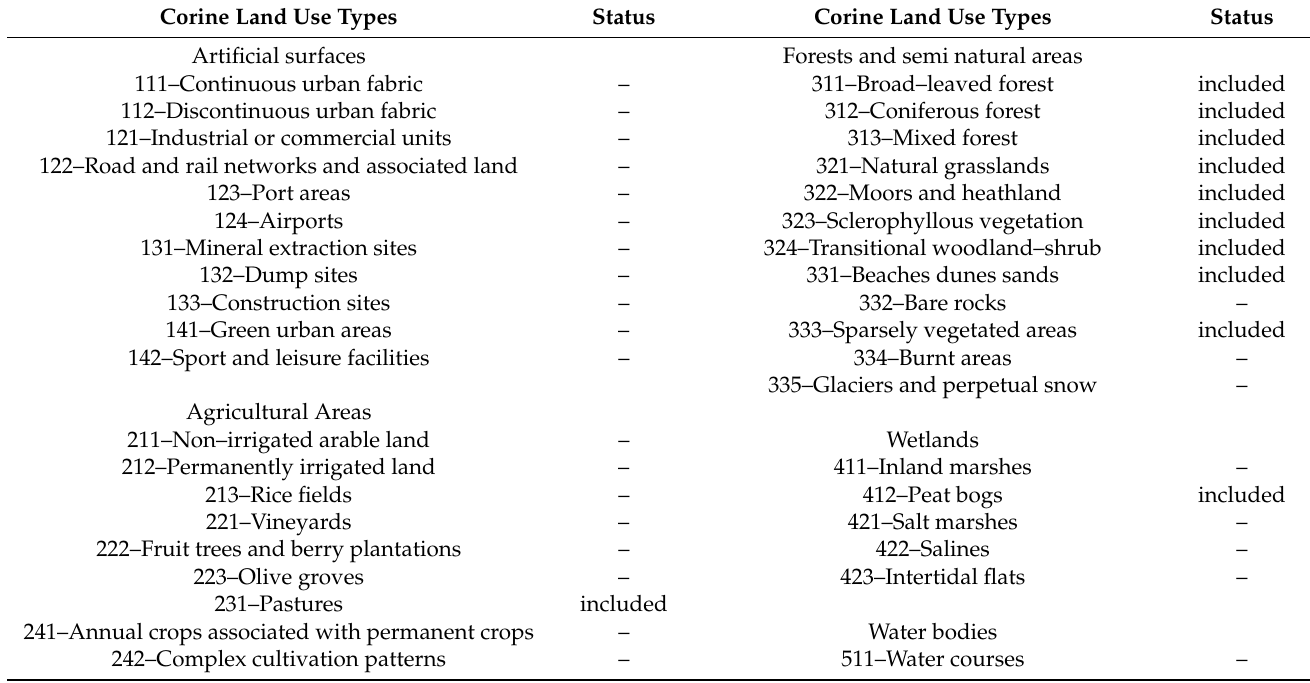
Table A1. List of all Corine land cover types that are included in the classification